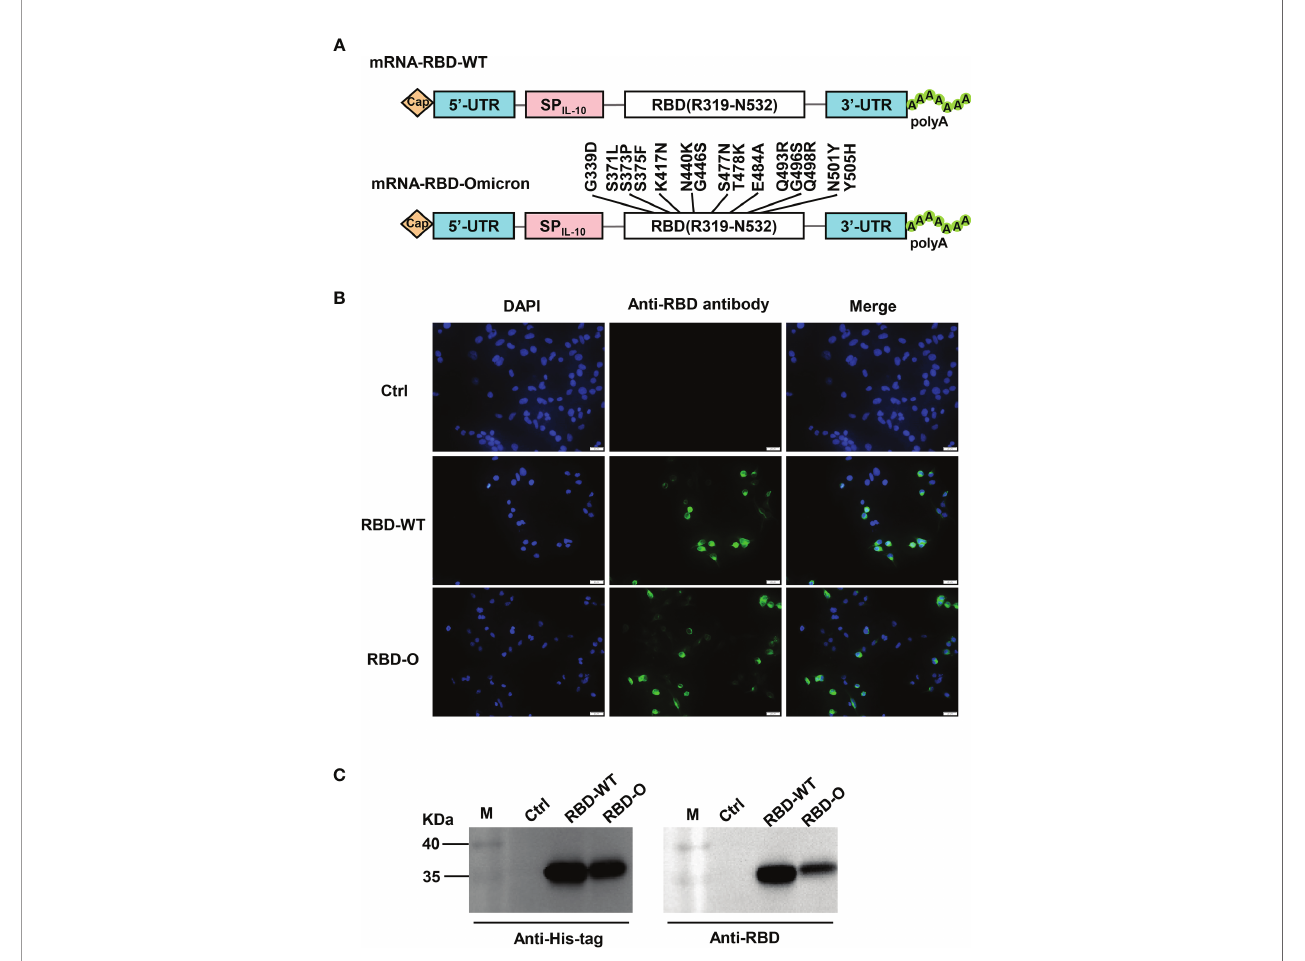
FIGURE 1 | Design and characterization of LNP-encapsulated RBD mRNA vaccines against SARS-CoV-2. (A) Schematic diagram of RBD-WT (top panel) and RBD- Omicron (bottom panel) mRNA framework. Note that 15 mutations are located within Omicron RBD. UTR, untranslated regions; SP IL-10 , human interleukin-10 signal peptide. (B) In vitro transcribed mRNA was transfected into HEK293T cells and the expression ofRBD proteins within the cells were analyzed by immuno fl uorescence staining analysiswith mouse anti-RBDpolyclonal antibody and anti-mouse Alexa Fluor ® 488 secondaryantibody. Ctrl,mRNA encoding luciferase. RBD-O,mRNA encoding RBD-Omicron. Overlay,merge of the blue (DAPI) and green (RBD) channels. Scalebars= 20 m m. (C) The culture supernatants of mRNA-transfected HEK293T cells were analyzed for RBDexpression bywestern blotting with HRP-conjugated anti-Histag antibody and anti-RBD polyclonal antibody as detection antibodies.